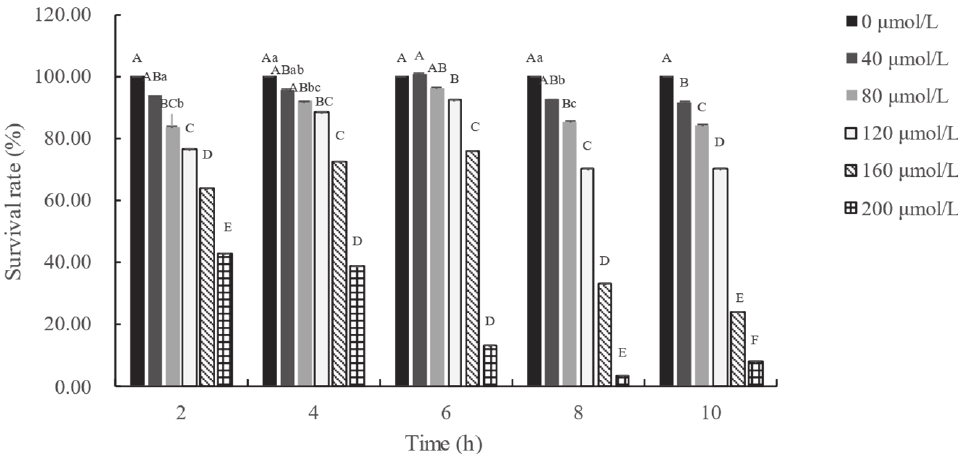
Figure 2. The effects of H 2 O 2 concentration and action time on the survival rate of IPEC-J2 cells. Note: This figure shows the survival rate of IPEC-J2 cells treated with different concentrations of H 2 O 2 (0, 40, 80, 120, 160 and 200 µ mol/L) at different times (2, 4, 6, 8 and 10 h). At each time point, compared with the 0 µ mol/L group, the difference was significant for different lowercase letters ( p < 0.05), the difference was extremely significant for different uppercase letters ( p < 0.01), and the difference was not significant for no letters or the same letter shoulder label ( p > 0.05).